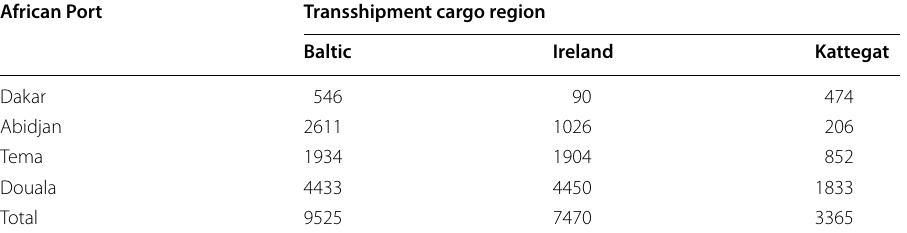
Table 7 Loading cargo volume [TEU] in each transshipment cargo region